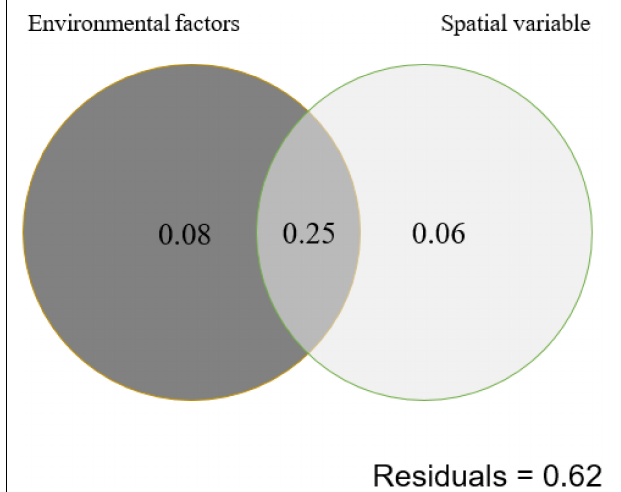
FIGURE 5 | Variation partition analysis (VPA) showing the contribution of environmental and spatial factors to shaping of the hydA gene diversity (at the OTU level) in the studied hot spring samples. Environmental factors contain elevation, pH, and temperature. Spatial variable contains PCNM1 and